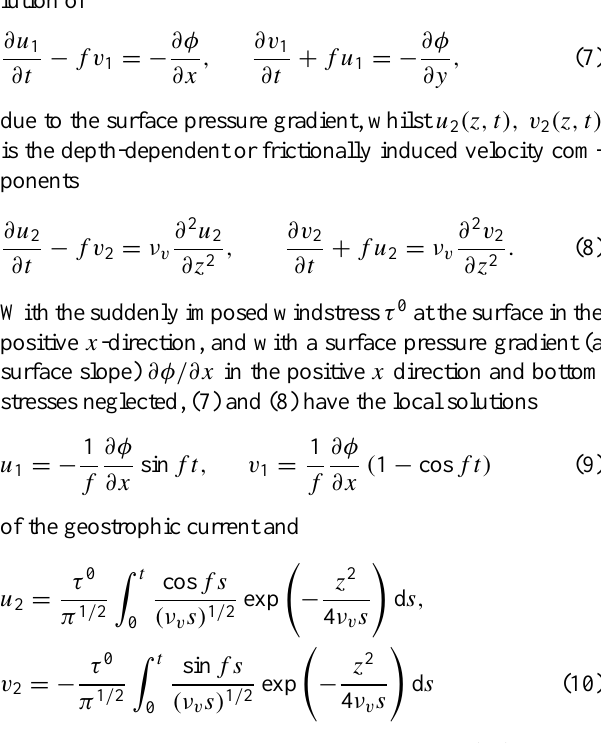
FIG. 4: Hodographs of the horizontal velocity vectors in the middle of the rectangular basin in 0, 5, 10, 20 and 60 m depth (a). In order to see the spiral at 20 m depth more clearly the 20 m hodograph is shown separately in (b). The motion starts from a state at rest. The small circles mark time intervals of 1/4 inertial period